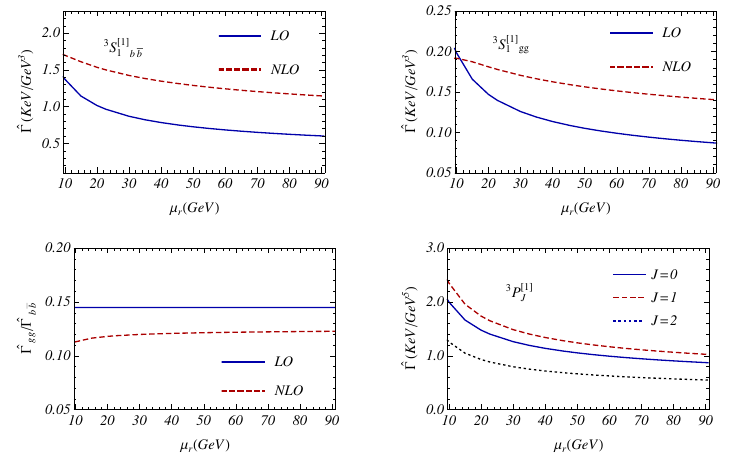
Figure 4 . SDCs of the CS processes. The subscript “ gg 00 stands for Z → b ¯ b [ 3 S [1] and “ b ¯ b 00 for Z → b ¯ b [ 3 S [1] ] + b + ¯ b [18], with ˆΓ gg / ˆΓ 1